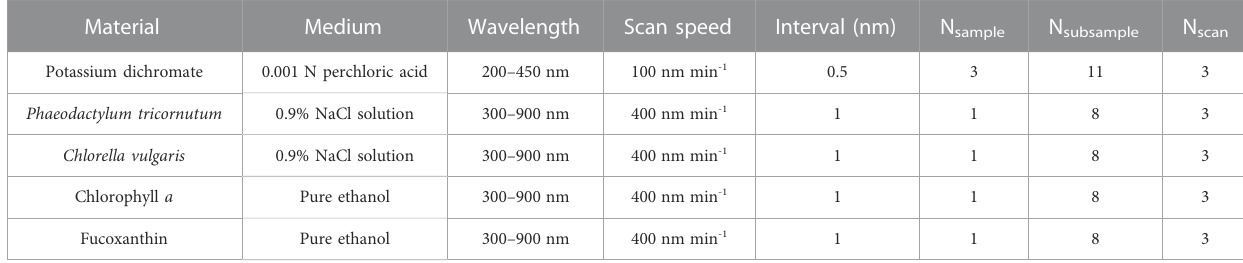
TABLE 3 Experimental setups of absorbance measurements for the potassium dichromate solutions, the microalgae suspensions and the pigment solutions. N sample is the number of samples prepared repeatedly. N subsample is the number of subsamples diluted from the samples as described in Tables 1, 2. N scan is the number of spectral scans repeated for each